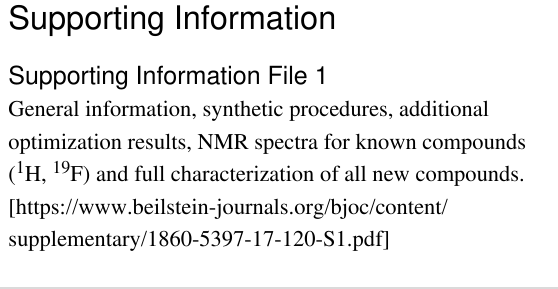
Finally, the Table of Content graphic was also corrected. The corrected version of the original graphical abstract is shown in Scheme